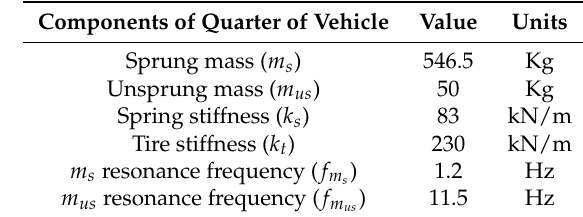
Figure 3. F-class vehicle physical dimensions. Table 3. Front QoV parameters.